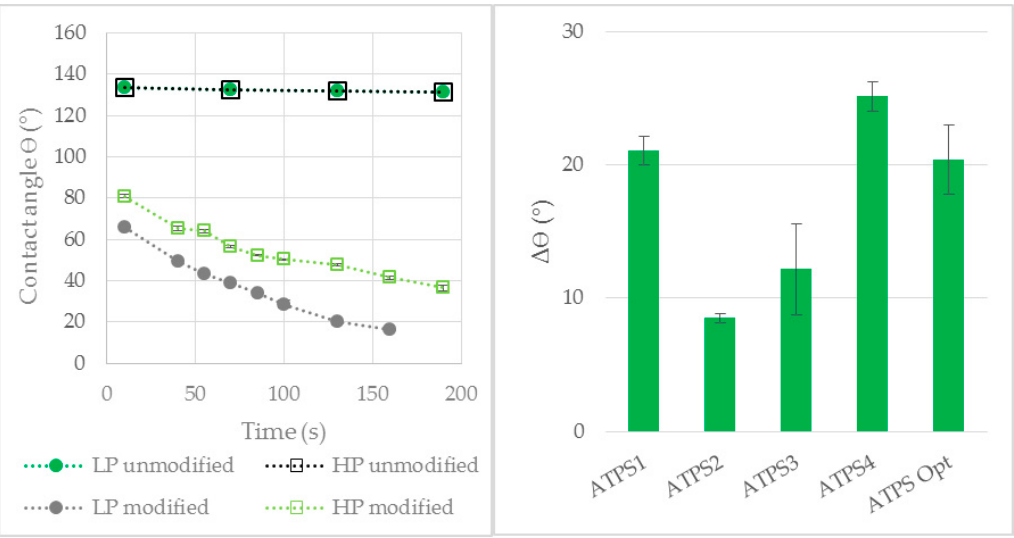
Figure 7. Contact angle of LP and HP on modified and unmodified PP membrane exemplified for ATPS4 as a function of time ( left ) and the contact angle differences ( right ) of ATPS1-4 and ATPS Opt (introduced in Section 3.3). LP: light phase. HP: heavy phase. PP: polypropylene.